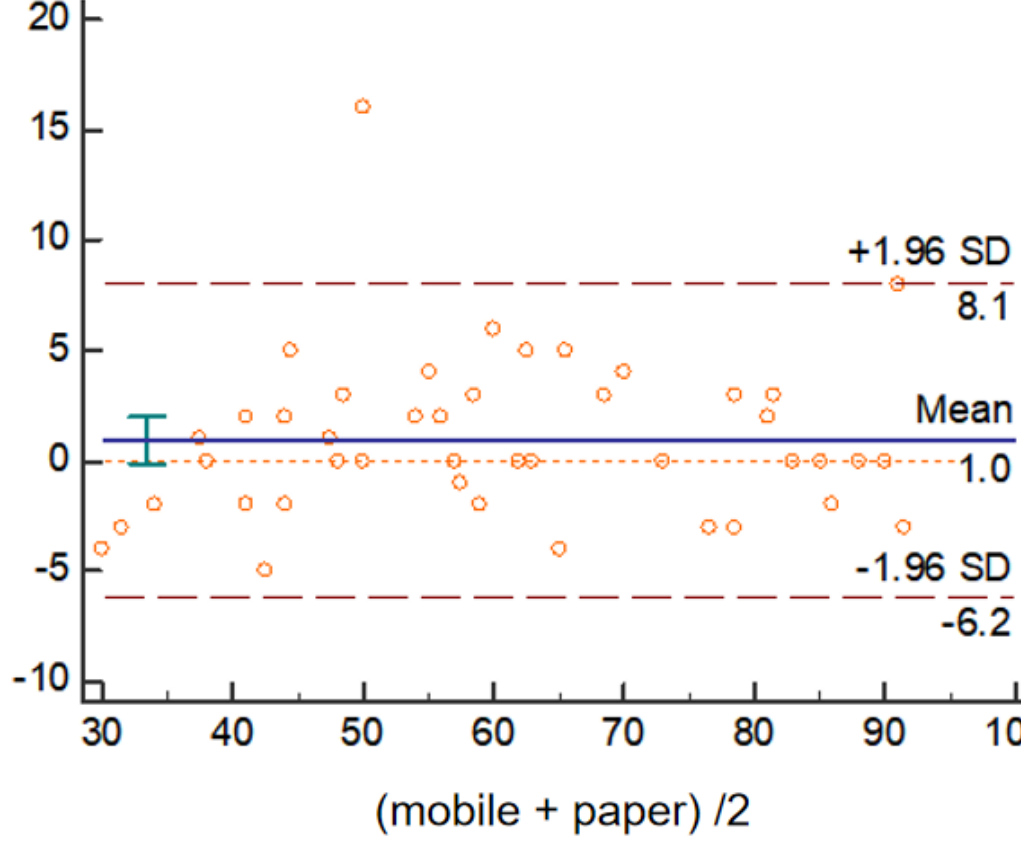
Figure 2. Bland-Altman plots between the paper and mobile versions of the ASES questionnaire. ASES: American Shoulder and Elbow Surgeons Standardized Shoulder Assessment Form.